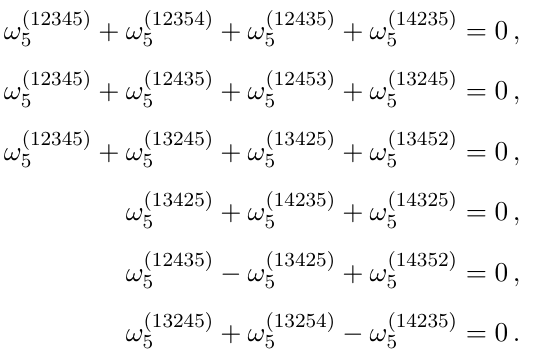
Figure 18 . Oriented sum of three associahedra for n = 5 giving rise to the KK relation ω (13425) + ω (14325) = 0 ω (14235) 5 5